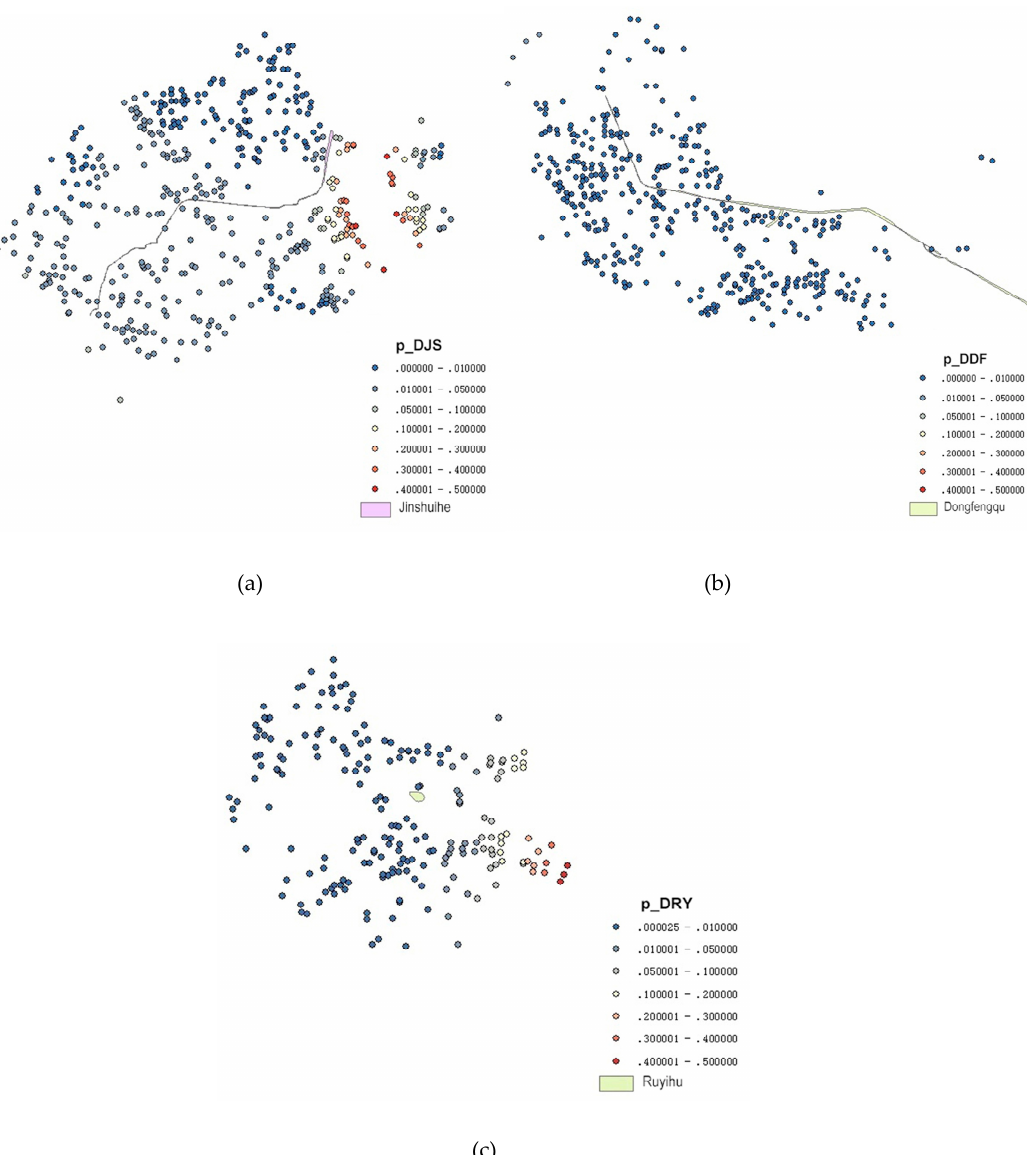
Figure 9. P-value distribution of distance to Jinshuihe ( a ), Dongfengqu ( b ) and Ruyihu ( c ).